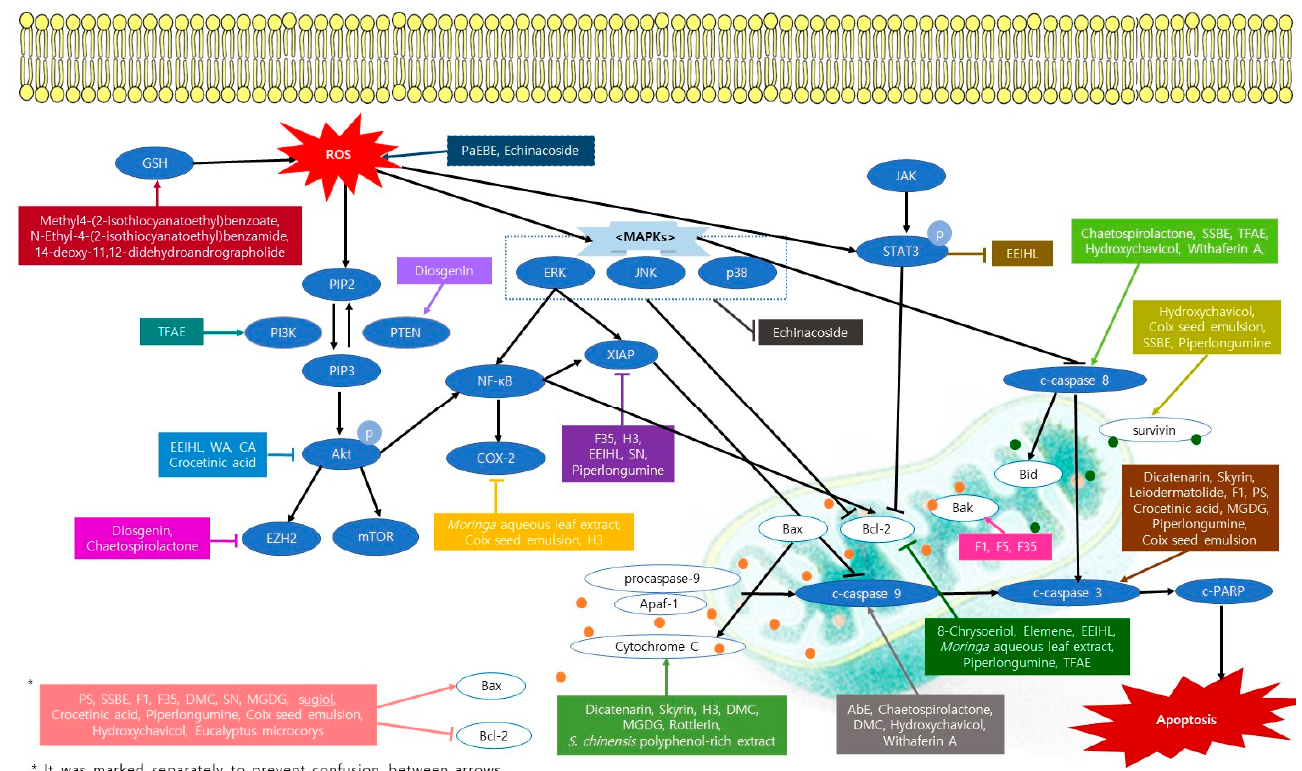
Figure 1. Schematic diagram of apoptotic mechanisms of various natural products against pancreatic cancer. The intrinsic apoptotic pathway is regulated primarily by anti-apoptotic Bcl-2 family of proteins. Bcl-2 inhibits release of mitochondrial cytochrome c. Cytochrome c which is released from the mitochondrial intermembrane forms the apoptosome complex in the cytosol with Apaf-1 and procaspase-9, leading to caspase-9 activation. Caspase-9 then activates effector caspases, resulting in some cleavages of cellular proteins and finally cell death by apoptosis. Several natural products such as 8-Chrysoeriol, Elemene, EEIHL, Moringa aqueous leaf extract, Piperlongumine, TFAE, PS, SSBE, F1, F35, DMC, SN, MGDG, sugiol, Crocetinic acid, Coix seed emulsion, Hydroxychavicol, and Eucalyptus microcorys down-regulated Bcl-2. Dicatenarin, Skyrin, H3, DMC, MGDG, Rottlerin, S. chinensis polyphenol-rich extract induced cytochrome c release to the cytosol. Some drugs affected on caspase-3, 8, and 9 straight without going through the process. Meanwhile, MAPKs signaling pathway, stimulated by ROS, could also inhibit anti-apoptotic Bcl-2 proteins. In addition to MAPKs, several processes triggered by ROS act directly or indirectly on apoptosis.